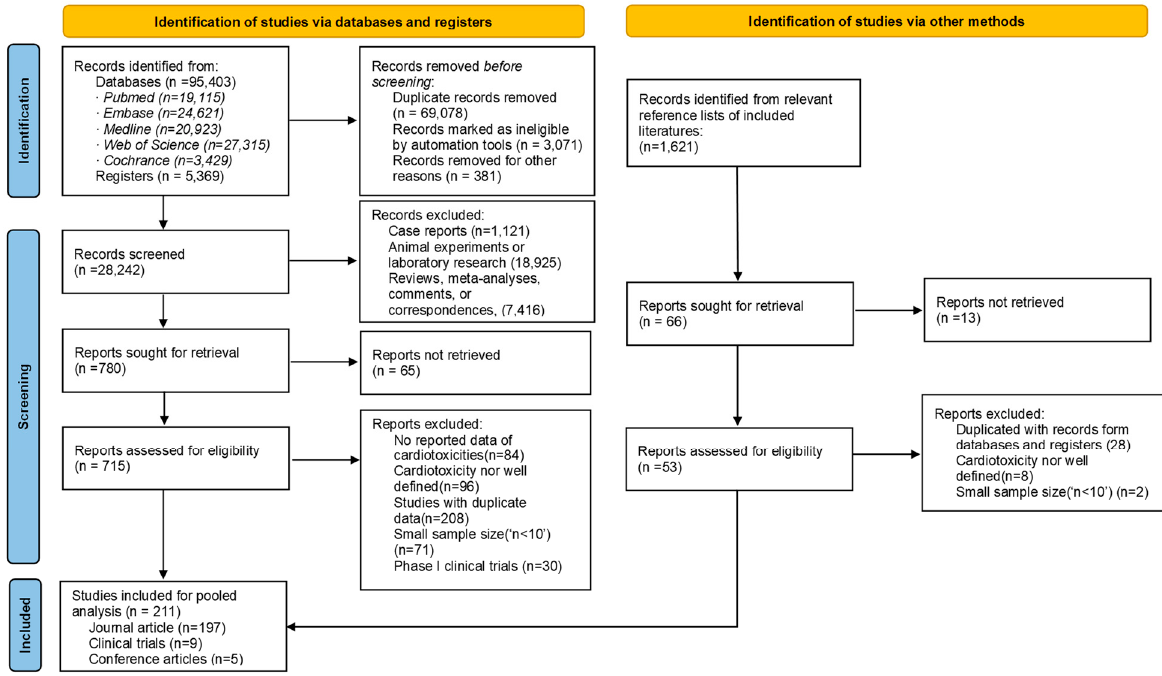
Figure 1. Flow diagram of the inclusion/exclusion process of the relevant literature with number of articles at each step.